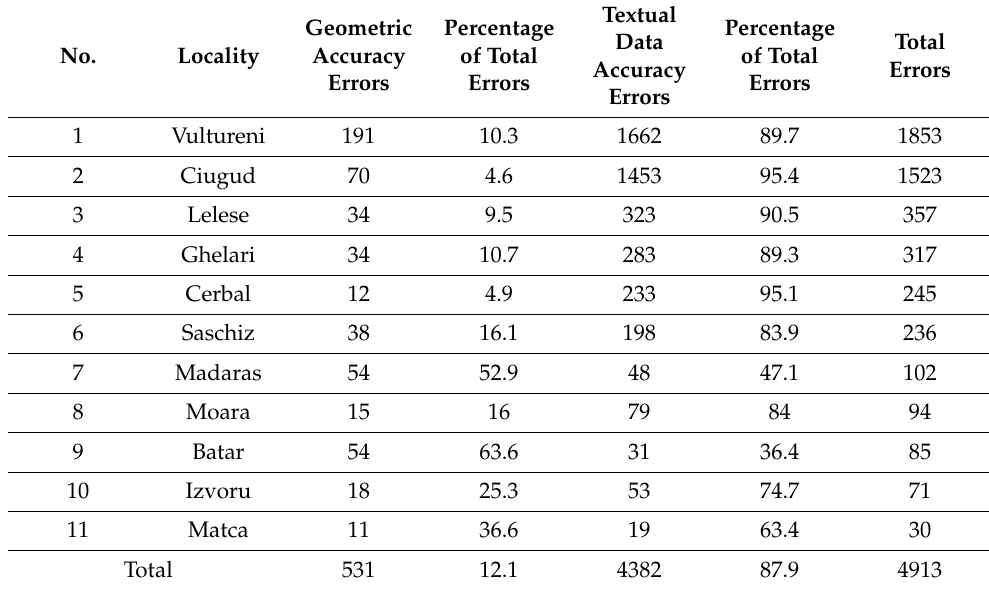
Table 7. Localities in which number of errors were counted from the rejection papers.